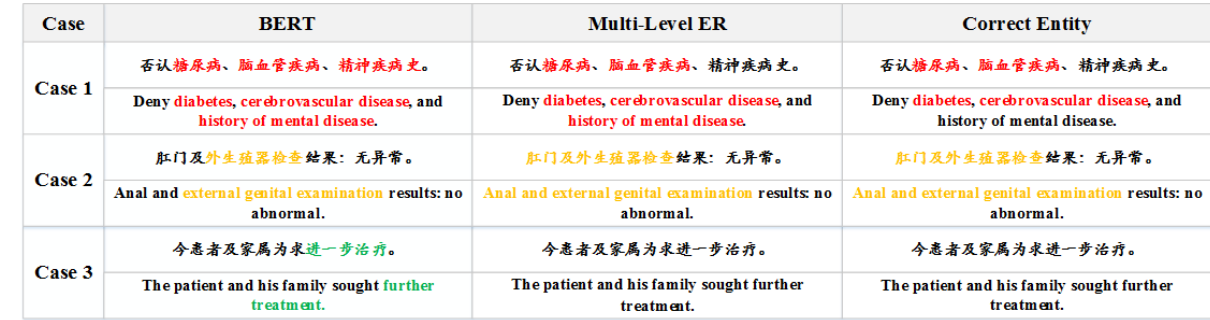
Figure 5. Case studies comparing the multi-level representation learning for entity recognition (Multi-Level ER) model with the Bidirectional Encoder Representations from Transformers (BERT)